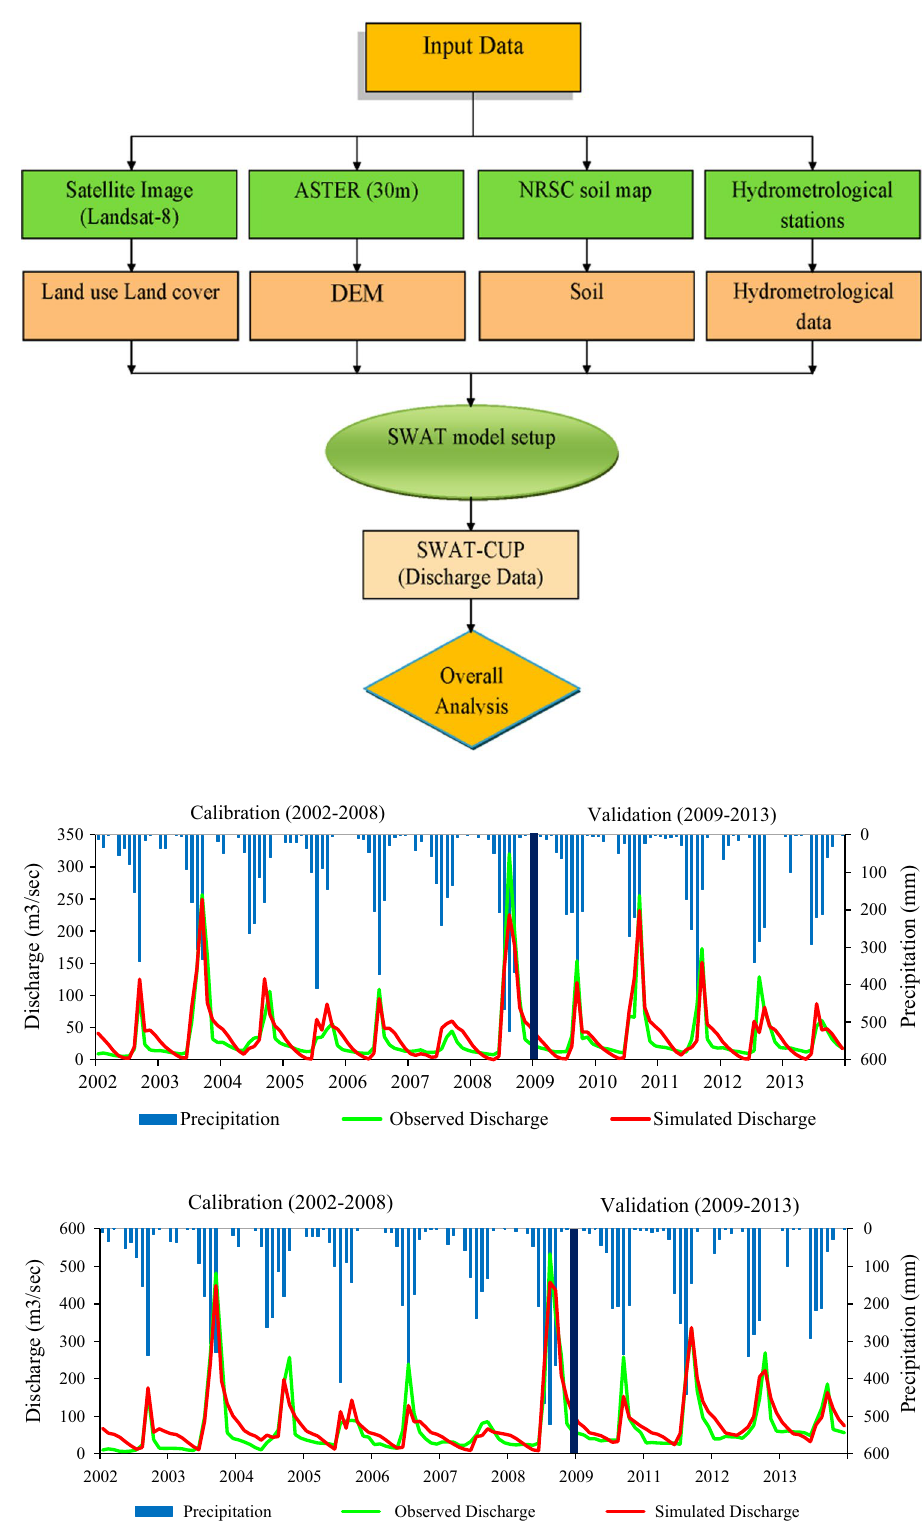
Fig. 7 Detailed methodological framework